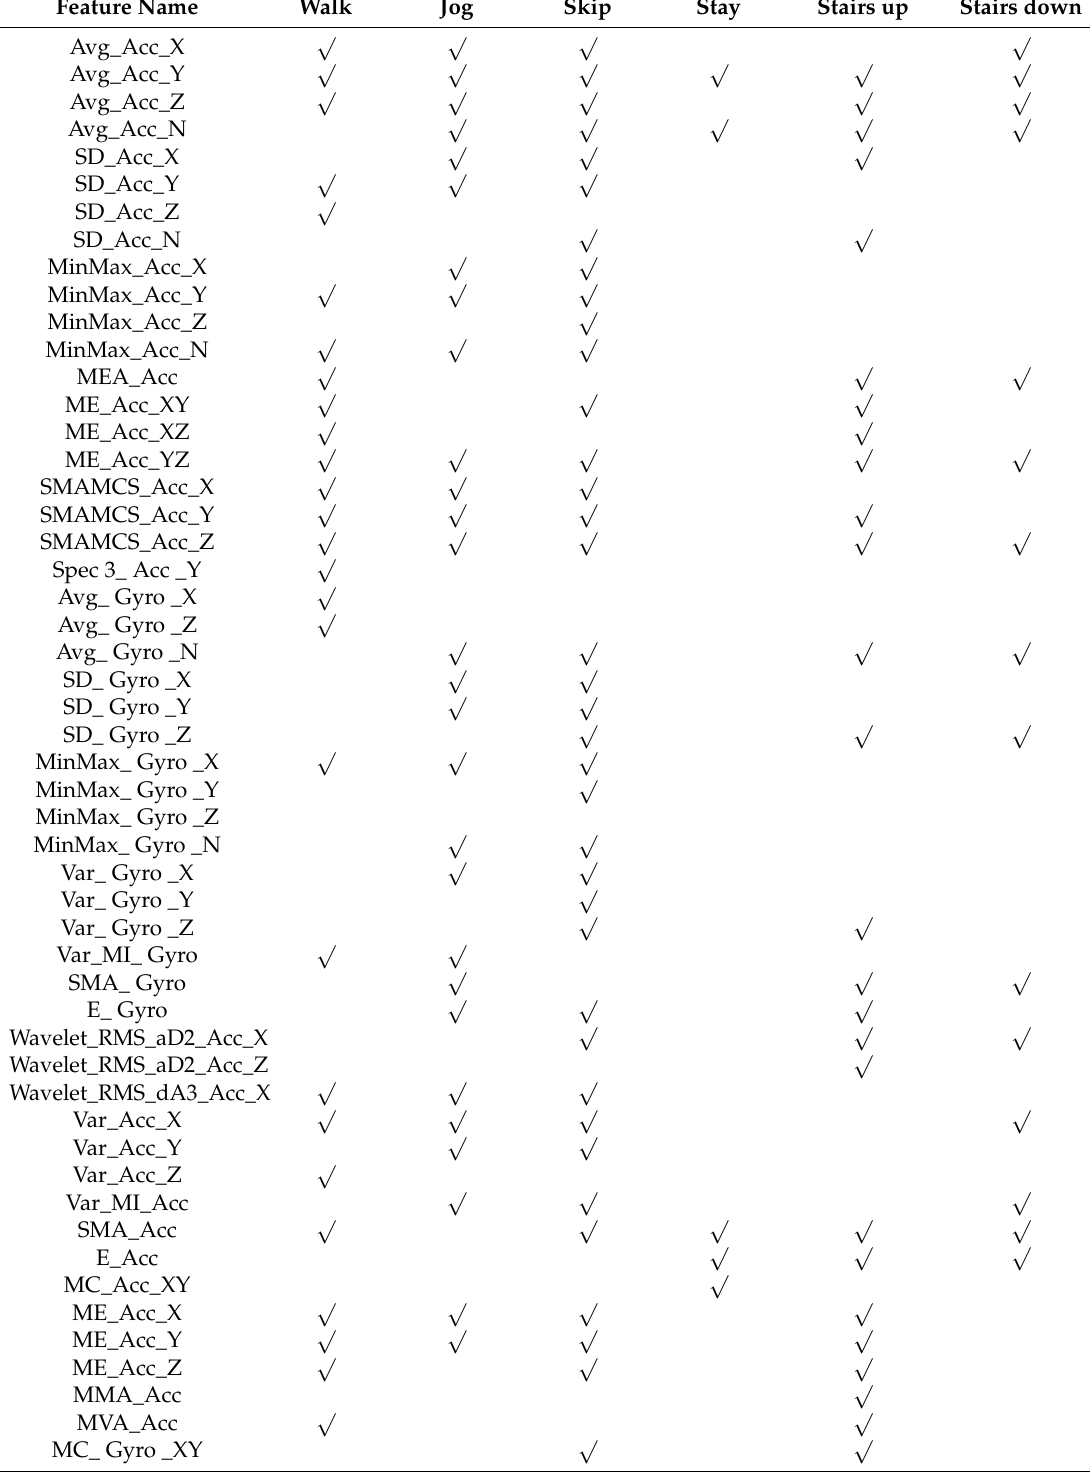
Table A5. The list of selected features due to the different activity datasets in the unbalanced